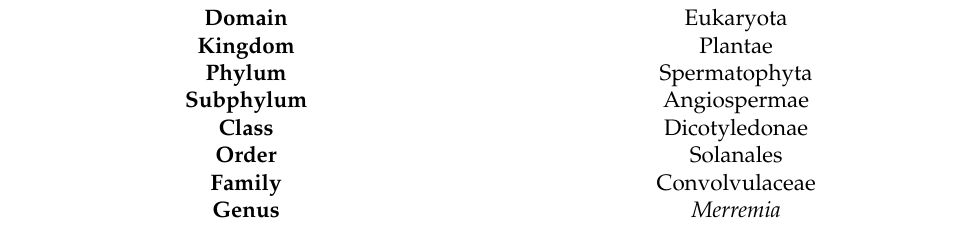
Table 3. Taxonomic classification of the genus Merremia